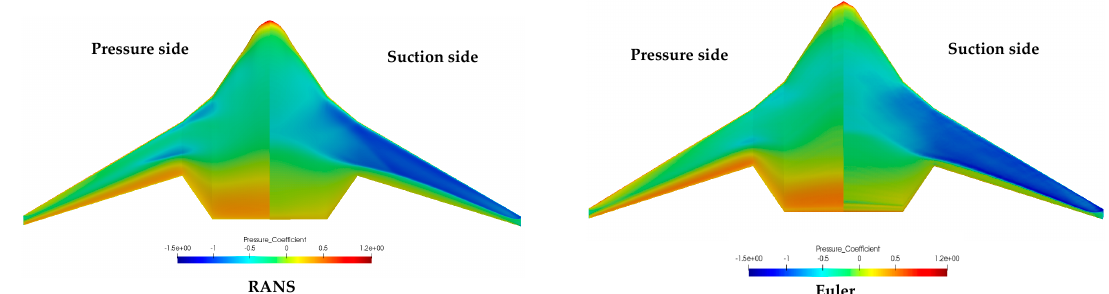
ffi cients for RANS and Euler simulations at AoA = 1 deg. Figure A16. Pressure coefficients for RANS and Euler simulations at AoA = 1 deg. Figure A16. Pressure coe